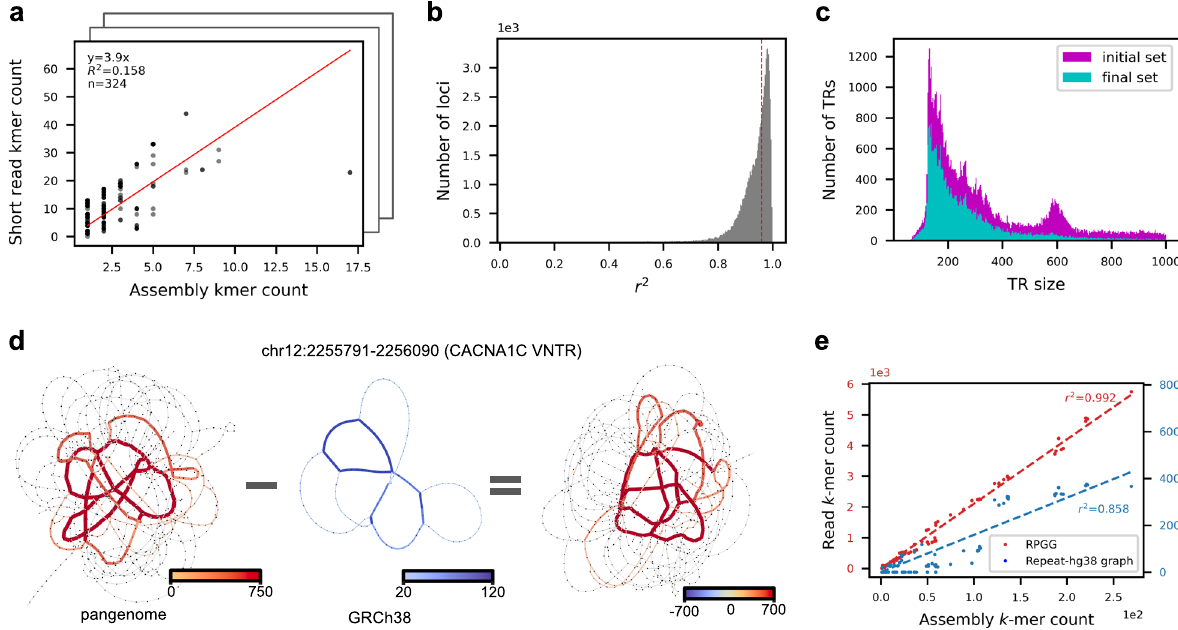
Fig. 2 Mapping short reads to repeat-pangenome graphs. a An example of evaluating the alignment quality of a locus mapped by SRS reads. The alignment quality is measured by the r 2 of a linear fi t between the k -mer counts from the ground truth assemblies and from the mapped reads (Methods). b Distribution of the alignment quality scores of 73,582 loci. Loci with alignment quality less than 0.96 when averaged across samples are removed from downstream analysis (Methods). c Distribution of VNTR lengths in GRCh38 removed or retained for downstream analysis. d , e Comparing the read mapping results of the CACNA1C VNTR using RPGG or repeat-GRCh38. d The k -mer counts in each graph and the differences are visualized with edge width and color saturation. To visualize paths with less mapped reads, k -mer counts are clipped at 750 (left), 120 (middle), and 700 (right), respectively, with the maximal k -mer count of each graph being 5744, 375, and 5378, respectively. e The k -mer counts from the ground truth assemblies are regressed against the counts from reads mapped to the RPGG (red) and repeat-GRCh38 (blue), respectively. Source data are provided as a Source Data fi